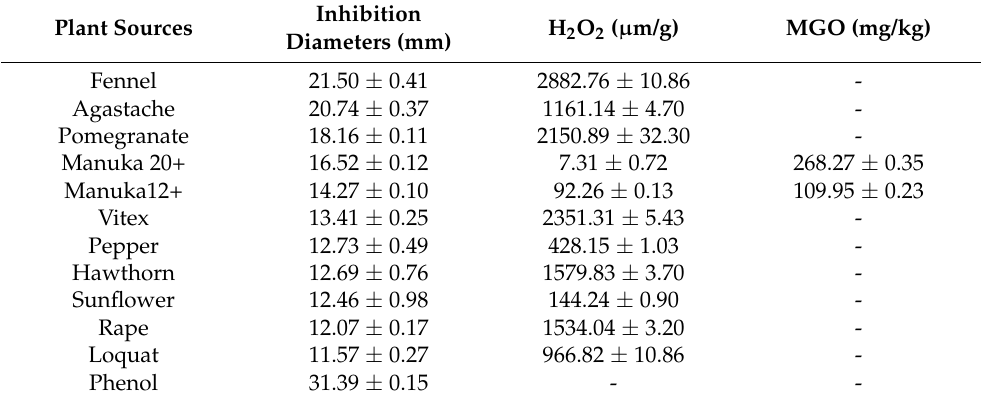
Table 3. The antimicrobial activity and main antimicrobial substance content of honey